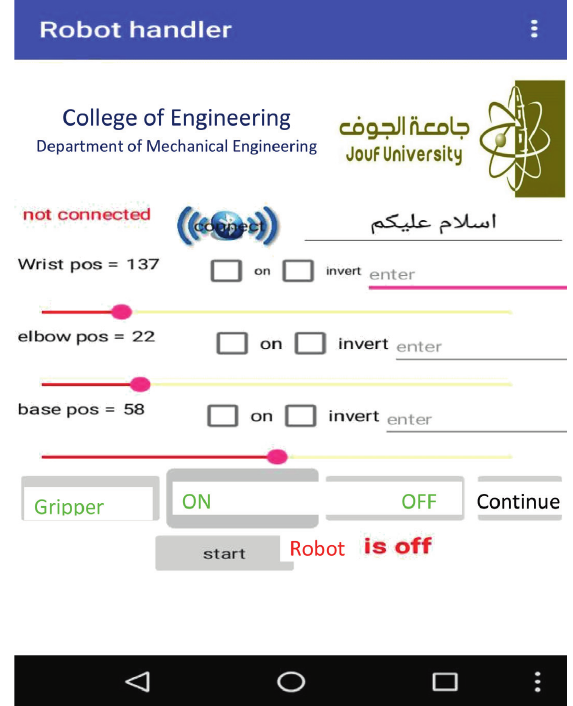
Figure 9: Visual graphical user interface screen.